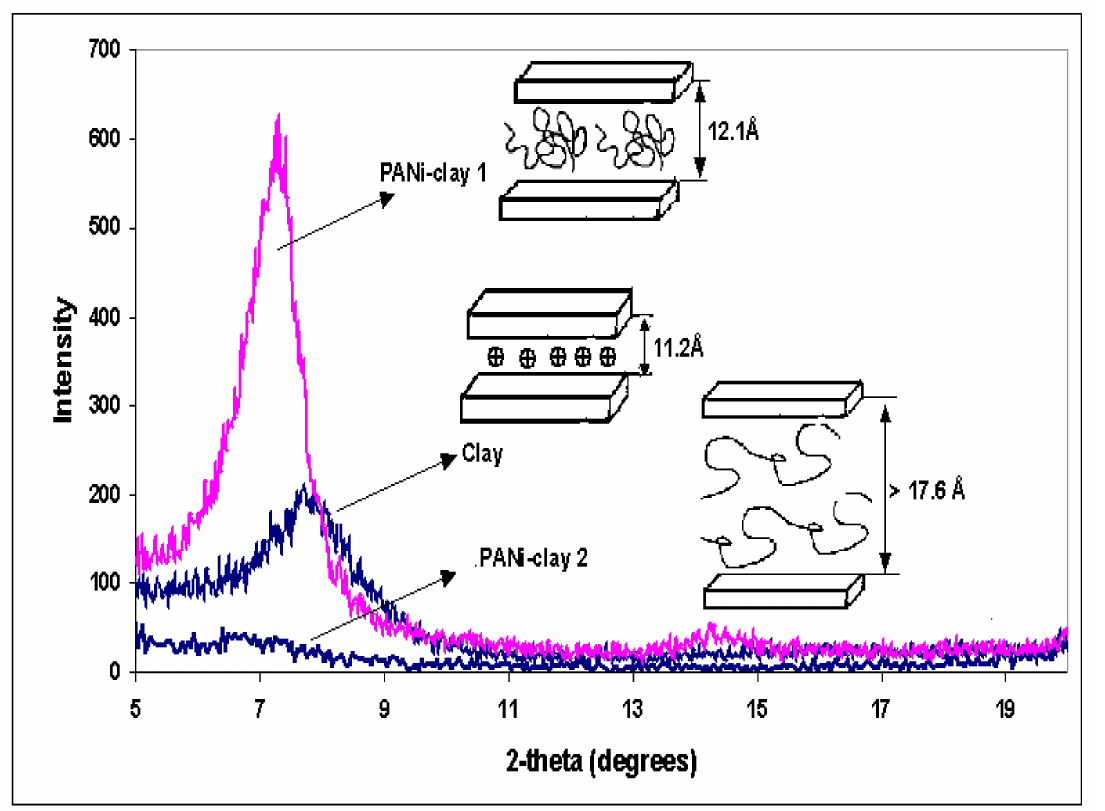
Figure 13. XRD patterns and schematic view of the corresponding structure of PACN synthesized by using Na + clay.